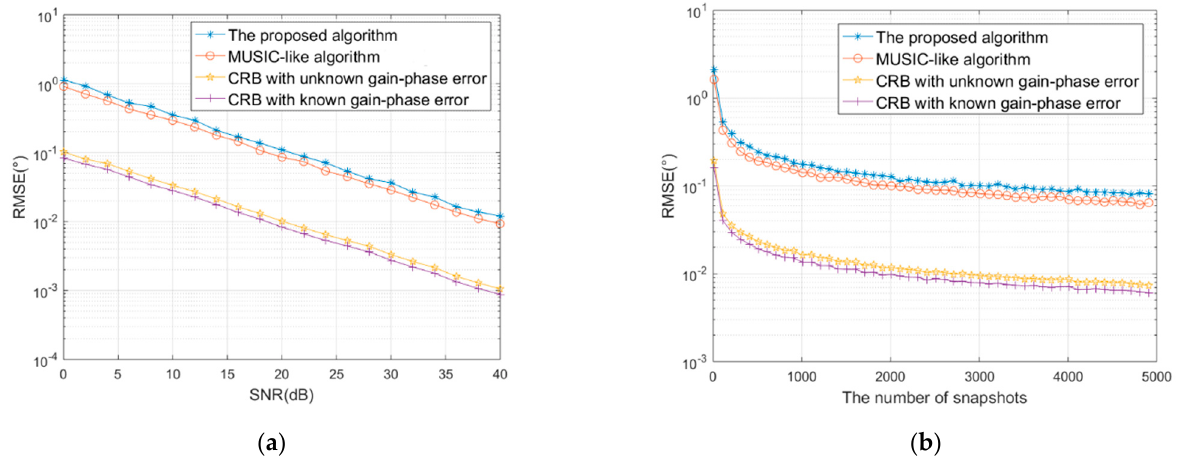
Figure 3. The RMSEs of 2D DOA estimation. ( a ) RMSE versus SNR; ( b ) RMSE versus